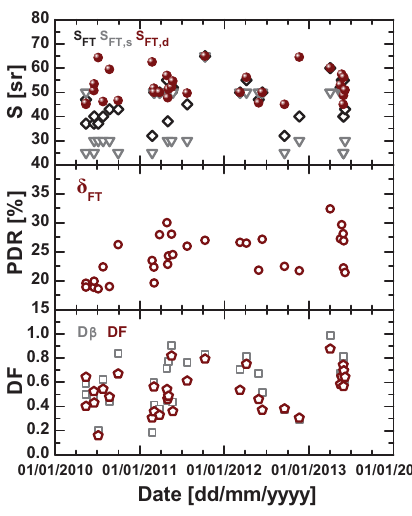
Figure 6. Same as Fig. 5, except for Saharan dust outbreaks.